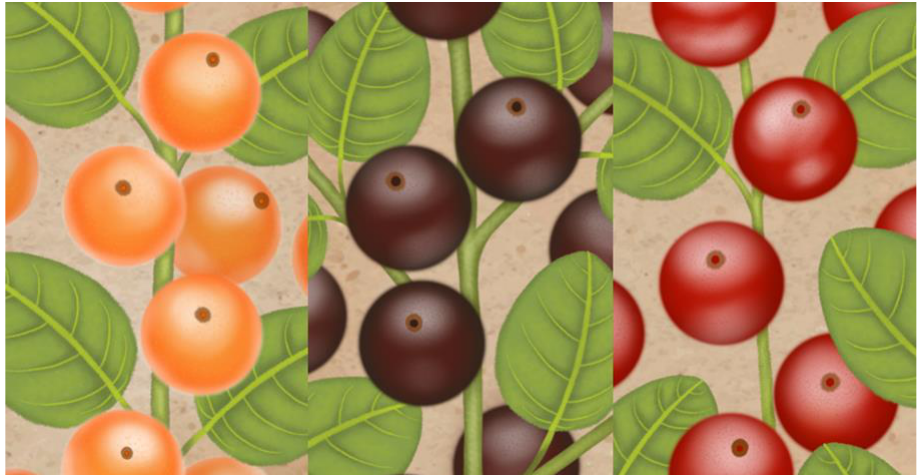
Figure 2. Orange, purple, and red cambuí fruits ( M. floribunda ). Illustration made by the Ribeiro, L.V.